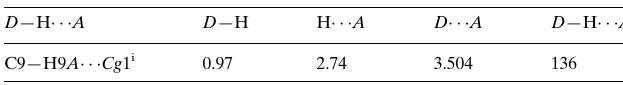
Hydrogen-bond geometry (A˚ , (cid:1)